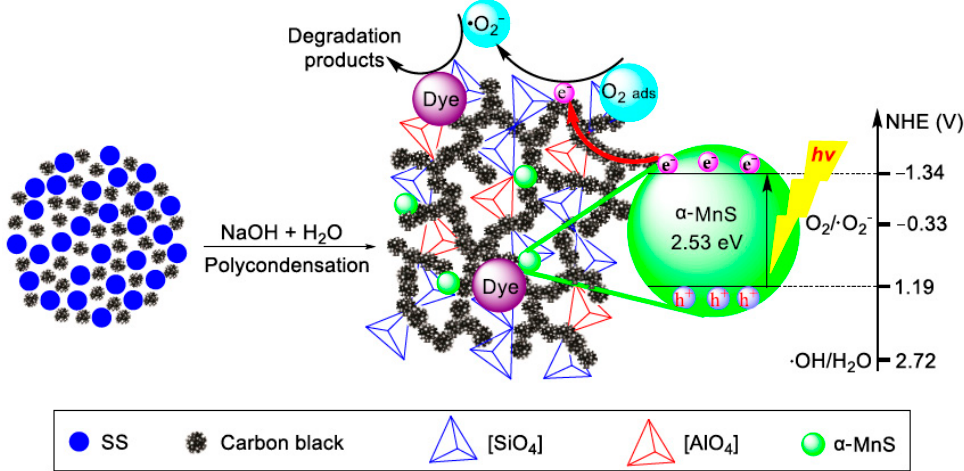
Figure 7. The trapping experiments of hydroxyl radical ( • OH), superoxide radical ( • O 2 − ) and photogenerated hole (h + ).